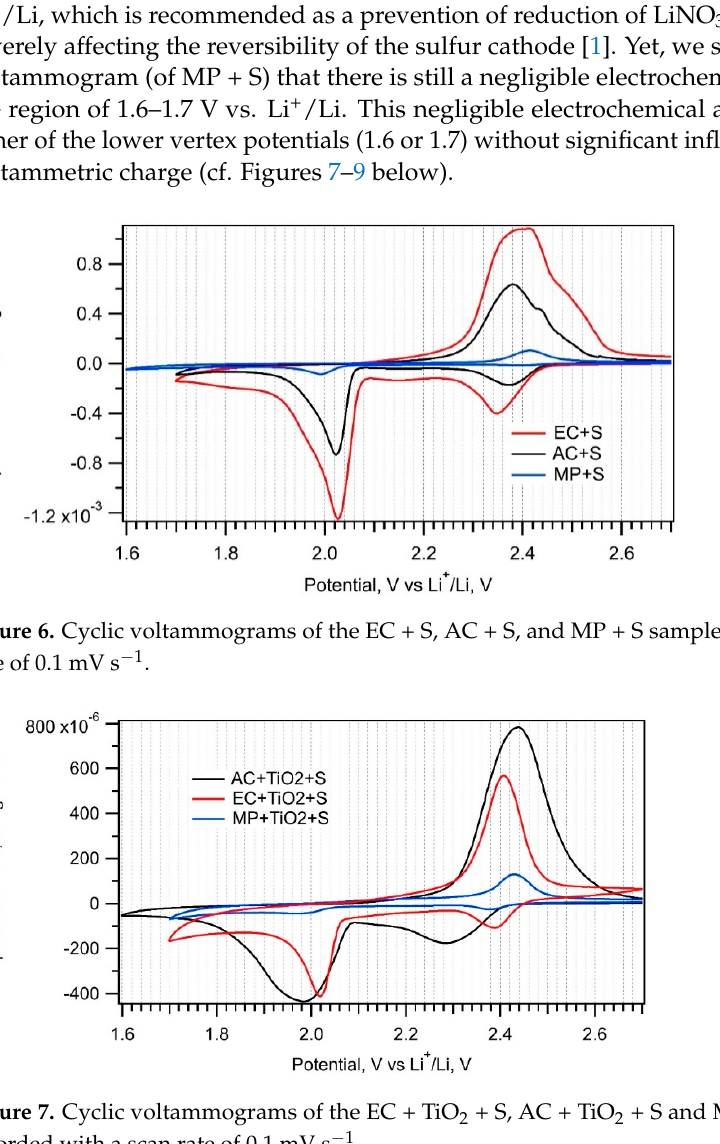
Figure 8. Cyclic voltammograms of EC + S and AC + S samples in cells without an interlayer (black curve) with the parent Sigracell interlayer (red curve) and with the Sigracell interlayer modified by metal oxide (TiO 2 -blue curve, SnO 2 -green curve) recorded with a scan rate of 0.1 mV s − 1 . Figure 9. Cyclic voltammograms of the AC + TiO 2 + S sample in cells without an interlayer (black curve), with the pure Sigracell interlayer (red curve) and with the modified Sigracell interlayer (TiO 2 —blue curve, SnO 2 —green curve) recorded with a scan rate of 0.1 mV s − 1 . Table 2 lists the charge capacities of all samples normalized to the mass of sulfur. The normalized cyclic voltammograms in Figure 6 show that the electrochemical performance of composites is significantly influenced by the particular carbonaceous additive. The charge capacities of the EC + S and AC + S samples (649 mAh g − 1 and 319 mAh g − 1 , respec- tively) correlate very well with the surface areas of the parent carbons, i.e., EC and AC